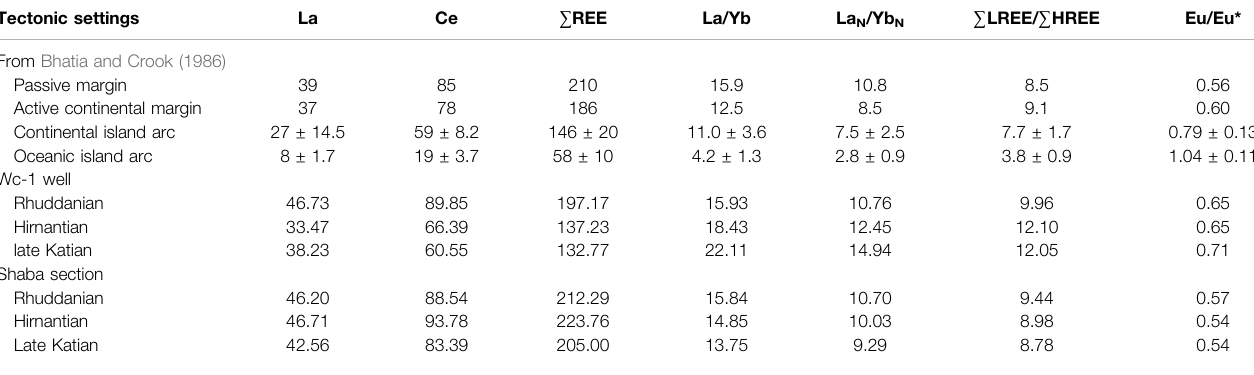
TABLE 3 | Comparison of the key rare earth element (REE) indices between this study and published literature. Tectonic settings La Ce (cid:6) REE La/Yb La N /Yb N (cid:6) LREE/ (cid:6) HREE Eu/Eu* From Bhatia and Crook (1986) Passive